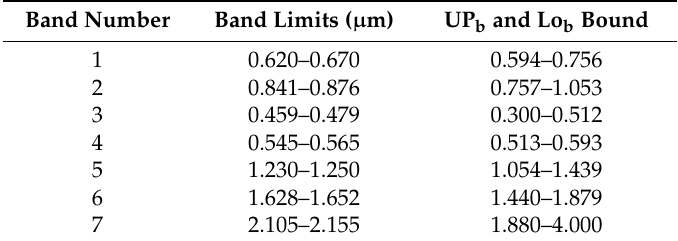
Table 3. MODIS band widths and ranges for UP b and LO b applied in Equation